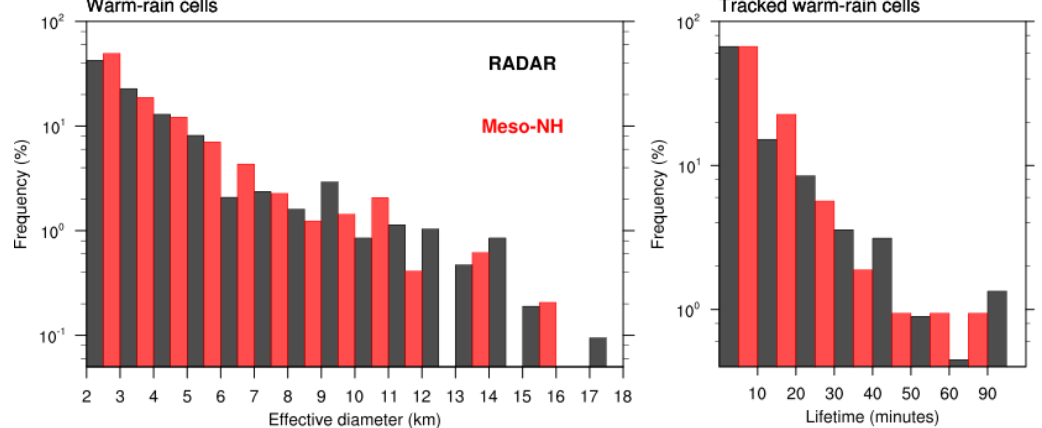
Figure 7. Left: histogram of the effective diameter of the warm-rain cells detected by the X-band radar (black) and simulated by Meso-NH (red) on 24 July 2016 between 03:00 and 08:00 UTC. The effective diameter corresponds to the diameter of a circle covering the same area than the warm-rain cell. As a recall, warm-rain cells must have a diameter larger than 2 km. There is a total of 1057 observed and 485 simulated warm-rain cells. Right: histogram of the lifetime of the observed (black) and simulated (red) tracked warm-rain cells, i.e., those detected at least twice, using an overlapping threshold of 20%. There is a total of 225 observed and 107 simulated